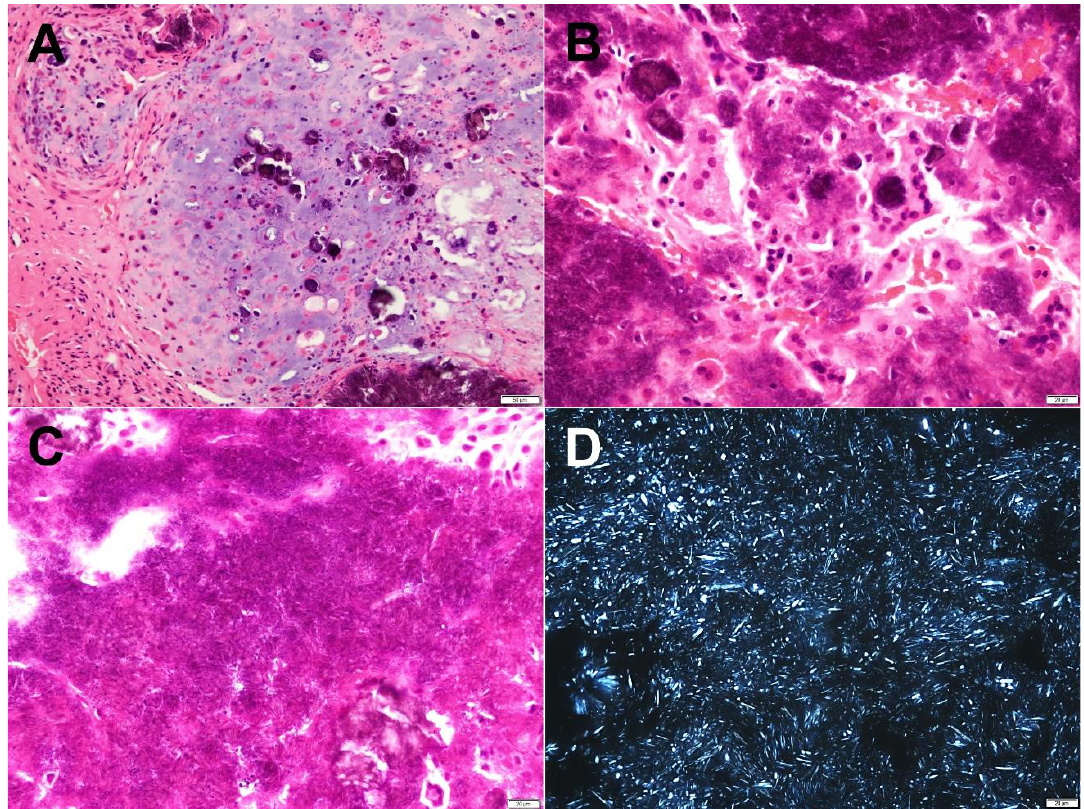
Figure 6. Histopathological examination. Representative specimen from the upper joint cavity showed the histopathological features of calcium pyrophosphate dihydrate deposition disease. ( A ) Chondroid metaplasia forms around basophilic islands of crystalline deposits. ( B ) A foreign body granulomatous reaction with multinucleated giant cells phagocytosing the crystals. ( C ) Deposited crystals appeared rhombus or needle shaped. ( D ) Under polarized light, these crystals demonstrated weak